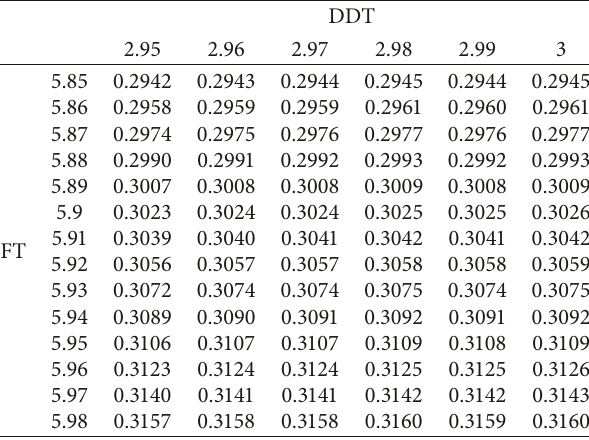
Table 3: Scores of different FT values and DDT values in linear degradation model.